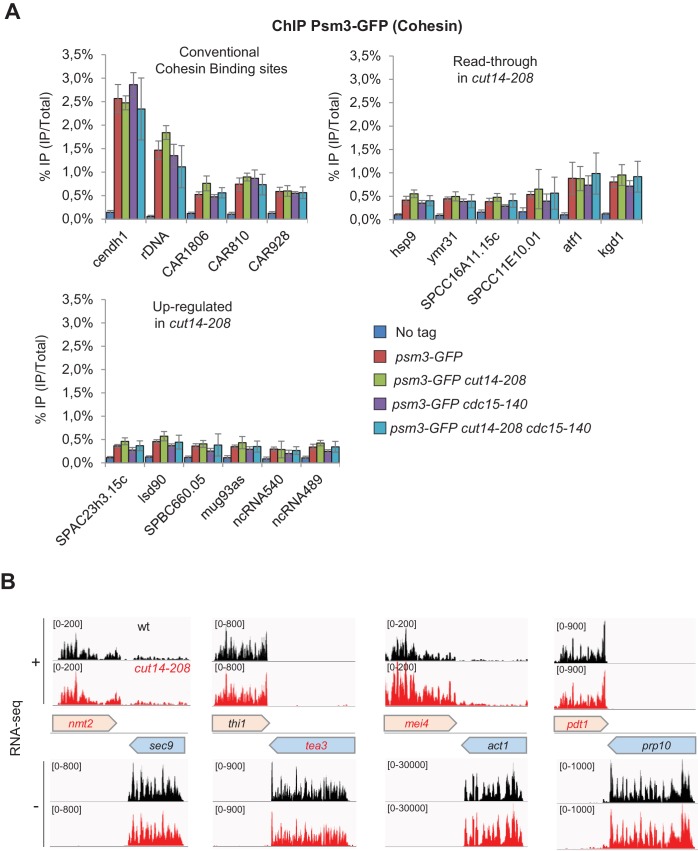
The condensin loss-of-function mutant cut14-208 accumulates 3’-extended read-through transcripts.(A) Cohesin localisation in cut14-208 condensin mutant cells. Indicated cells were grown at 36°C for 2.5 hr and processed for ChIP against the Psm3 subunit of cohesin tagged with GFP. Psm3-GFP occupancy was assessed at known, conventional cohesin binding sites (Feytout et al., 2011; Schmidt et al., 2009), and at genes showing either read-through transcripts or up-regulate RNAs, in cut14-208 cells. Show are averages ± SDs calculates from 6 ChIPs performed on biological triplicates. (B) Representative strand-specific RNA-seq profiles of the co-transcribed convergent gene pairs nmt2-sec9, tea3-thi1, mei4-act1 and pdt1-prp10 in cut14-208 mutant cells compared to wt. DNA strands (+or -) are indicated.